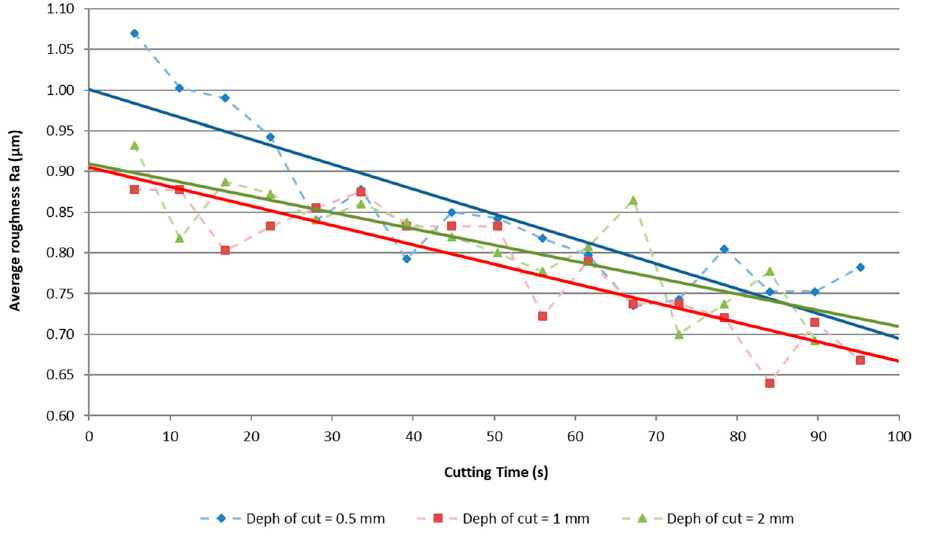
Figure 13. Ra evolution as a function of machining time (Vc = 100 m / min; f = 0.1 mm / rev). Solid lines represent linear trends.